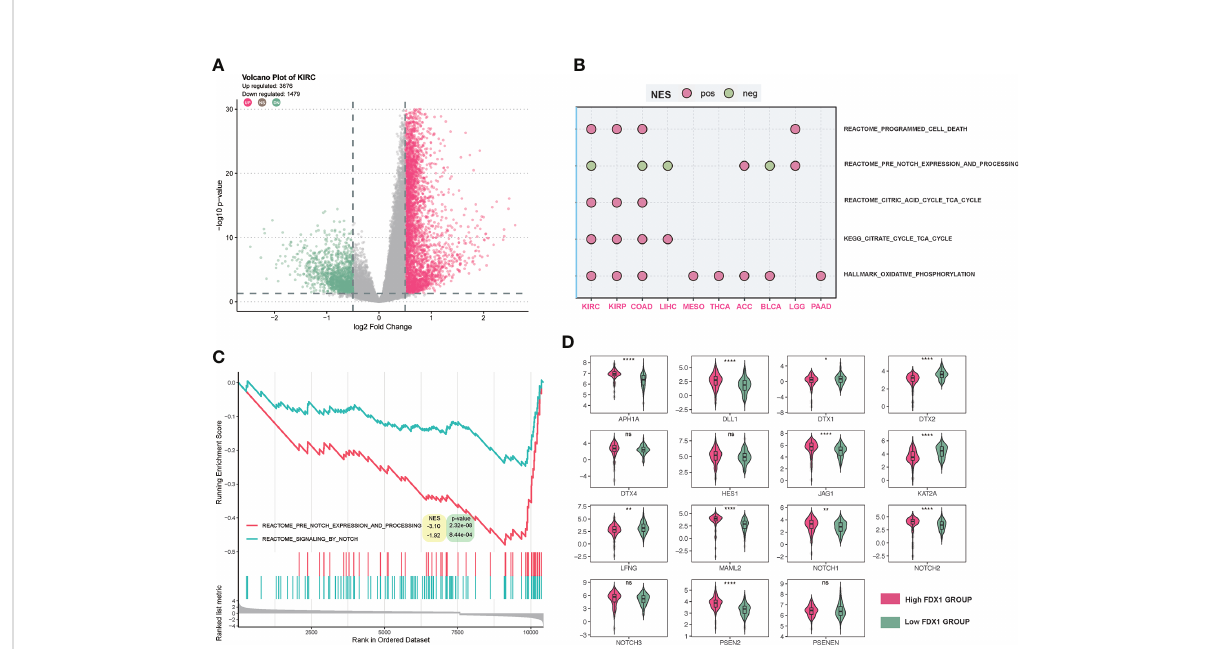
FIGURE 8 Gene set enrichment analysis (GSEA) of FDX1 in KIRC. (A) Differentially expressed genes based on the FDX1 expression 50% cutoff grouping and the volcano plot. The red spots mean upregulated genes, and the green spots mean downregulated genes. (B) Dot plot of GSEA in 10 cancer types. The red dot means that the gene set is enriched in the high- FDX1 group, while the green dot means that the gene set is enriched in the low- FDX1 group. (C) The GSEA plot of the NOTCH-related gene sets. (D) The expression of the 15 NOTCH pathway genes between high- and low- FDX1 groups (50% cutoff). p ≥ 0.05, *p < 0.05, **p < 0.01, ****p <